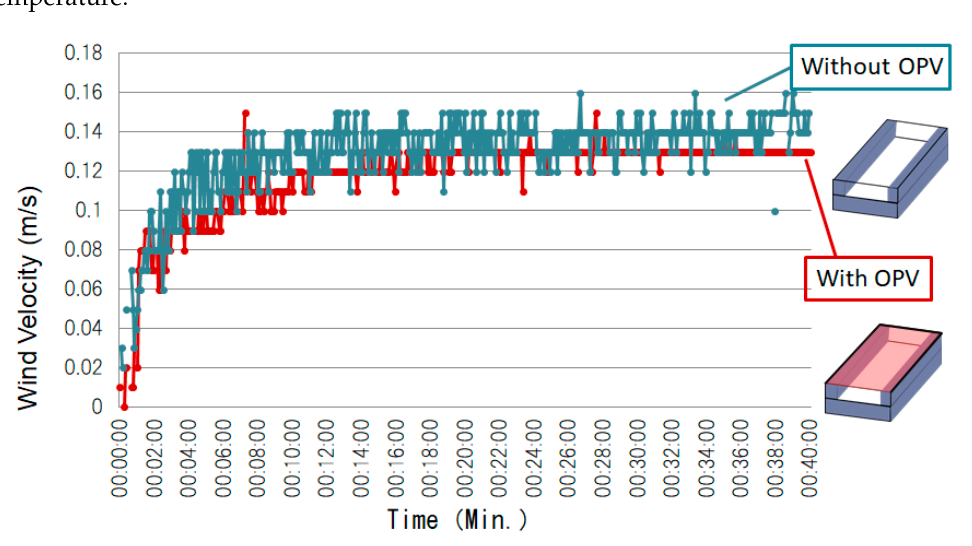
Figure 8. Thermal profile during 24 h in winter.